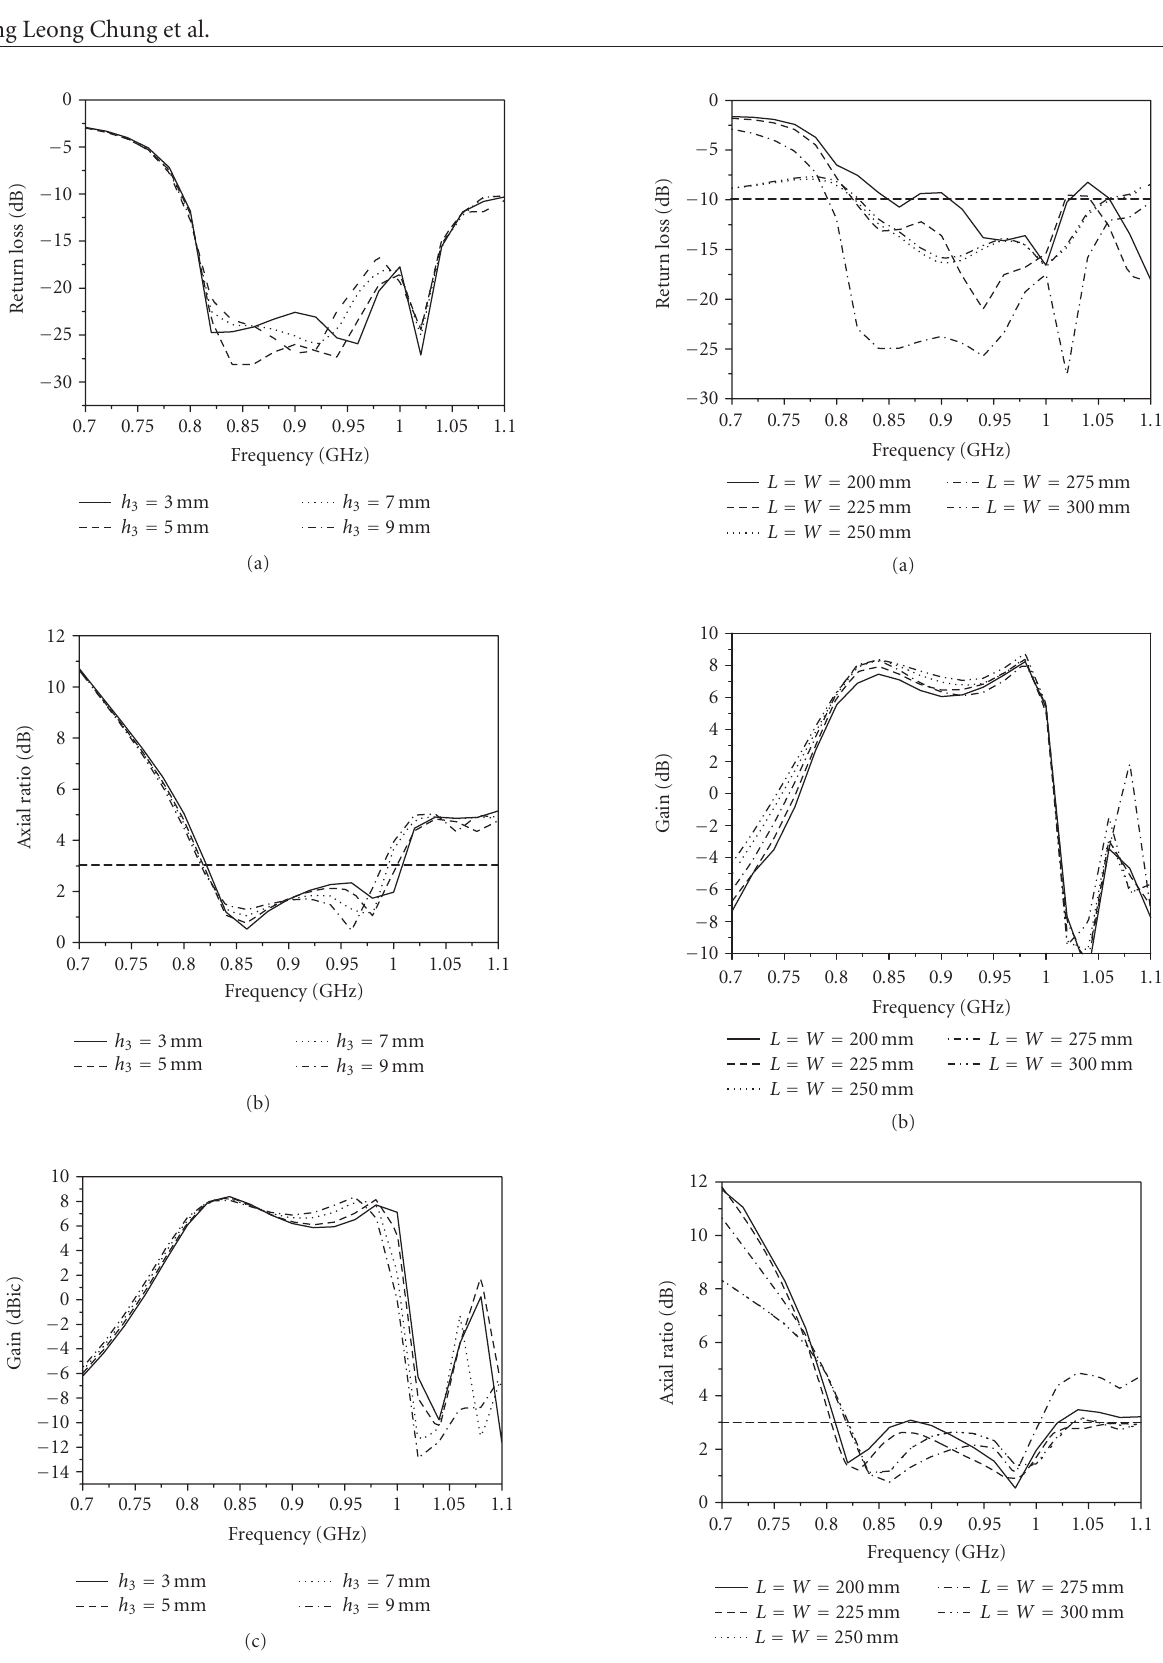
Figure 12: E ff ect of the size of the ground plane on the performance of the proposed antenna: (a) return loss; (b) gain; (c) axial